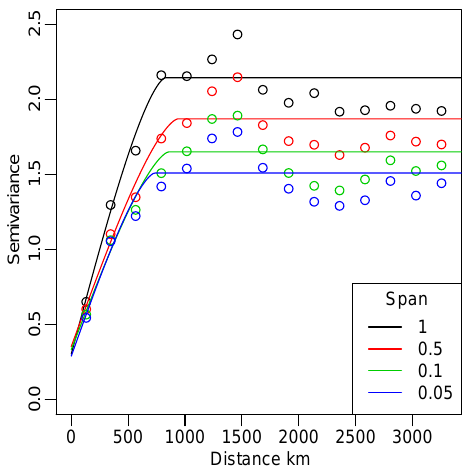
Figure 4. Empirical semi-variograms with circular variogram mod- els of the weighted averaging (WA) residuals of the planktonic foraminifera calibration data set (Kucera et al., 2005). The residu- als are detrended with locally weighted regressions (LOESS) using different